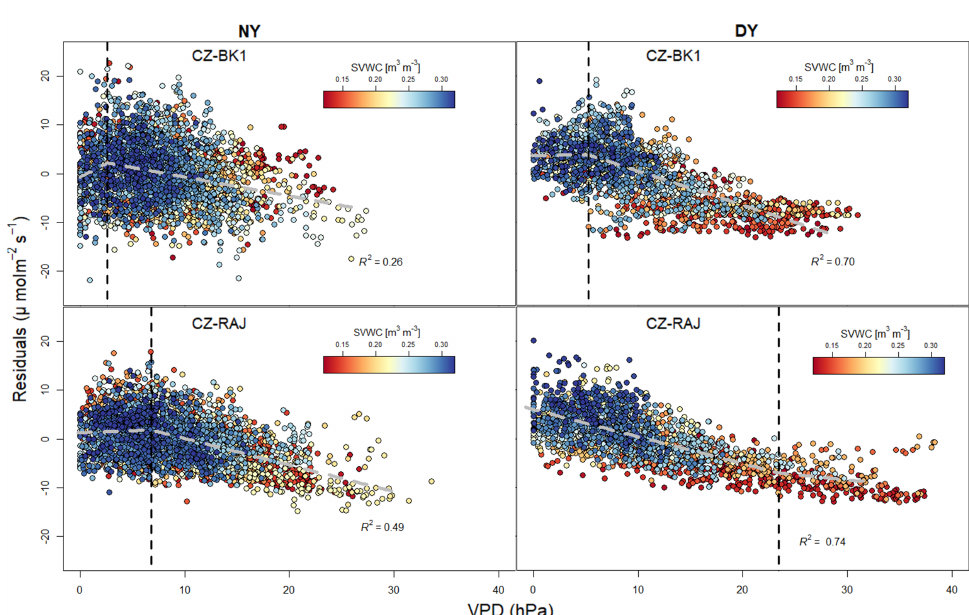
Figure 3. Relationship between the light response curve (LRC) residuals of the light response curve of gross primary production and the vapour pressure deficit (VPD) at the spruce forest sites in CZ-BK1 and CZ-RAJ for the normal (NY) and dry years (DY). Red represents low SVWC conditions and blue shows high SVWC conditions. The grey dashed lines represent the piecewise regression model slope, whereas the black dashed lines show the breakpoint values.